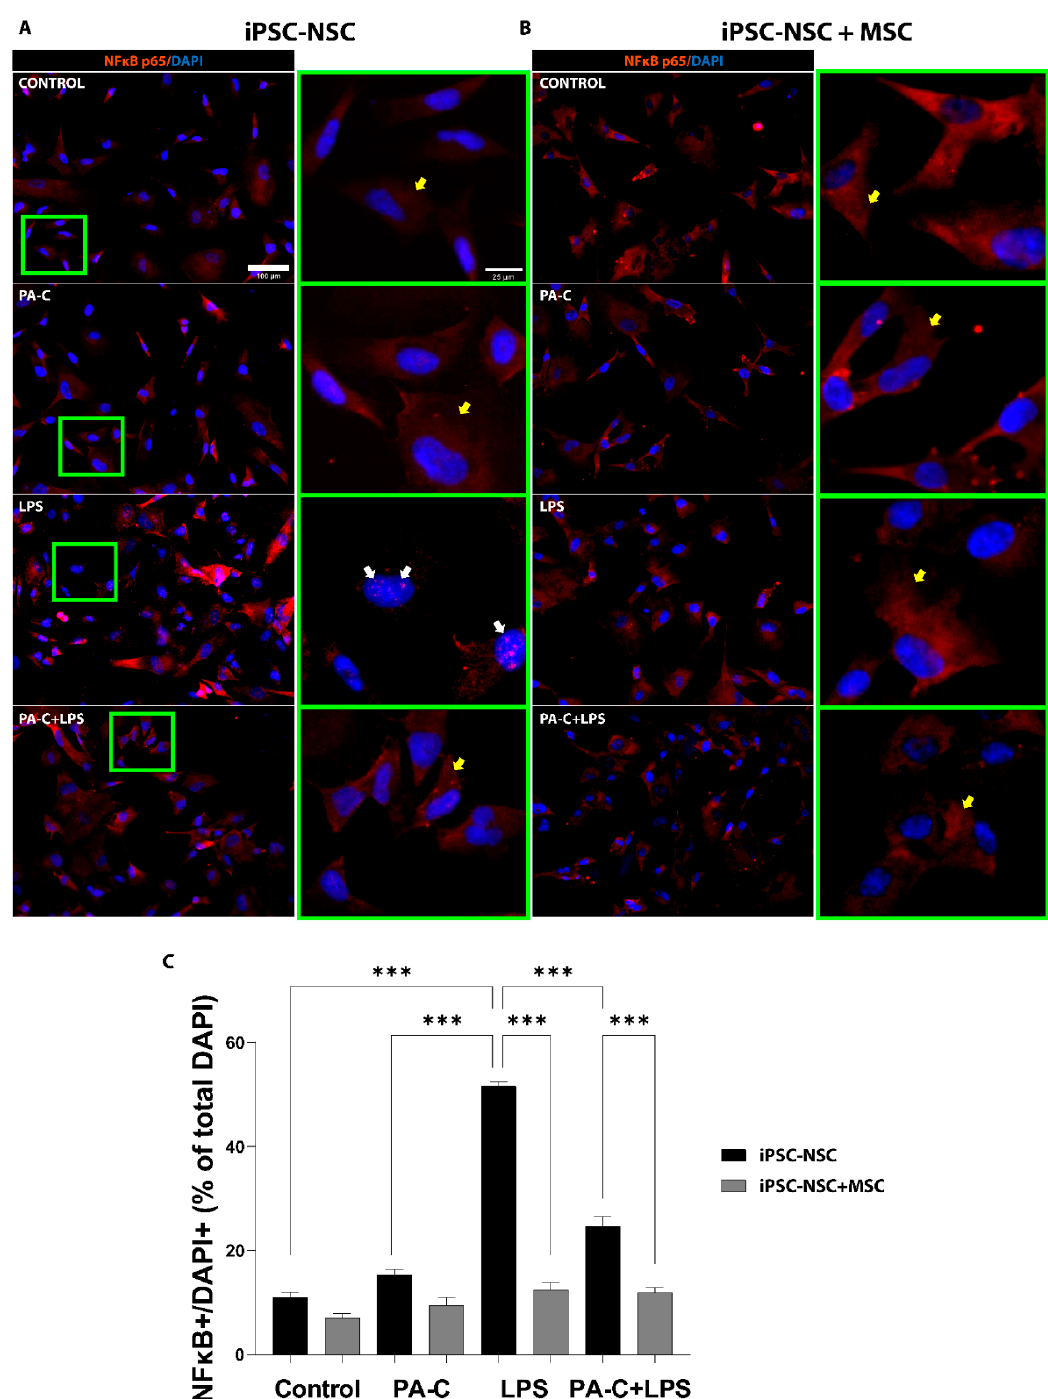
Figure 4. PA-C pre-treatment and MSC co-culture prevent NF- κ B translocation/activation in iPSC-NSC following pro- inflammatory LPS insult. ( A , B ). Representative immunostaining images of the NF- κ B inflammatory marker (orange) and nuclear staining DAPI (blue) in iPSC-NSC monoculture (iPSC-NSC) ( A ) and MSC co-culture (iPSC-NSC + MSC) ( B ) incubated for 24 h with 10 µ M PA-C or vehicle and then incubated with LPS (1 µ g/mL) or vehicle for 24 h (scale bar = 100 µ m). Green squares show higher magnification of the nuclei (scale bar = 20 µ m), with white and yellow arrows indicating nuclear and cytosolic NF- κ B, respectively. ( C ). Quantification of NF- κ B translocation by quantifying iPSC-NSC with nuclear NF- κ B (NF- κ B+/DAPI+) expressed as a percentage of the total number of iPSC-NSC by DAPI. Data expressed as mean ± S.E.M. (at least eight random fields from three independent experiments) determined by one-way ANOVA with Tukey’s multiple comparison test (*** p < 0.001 as